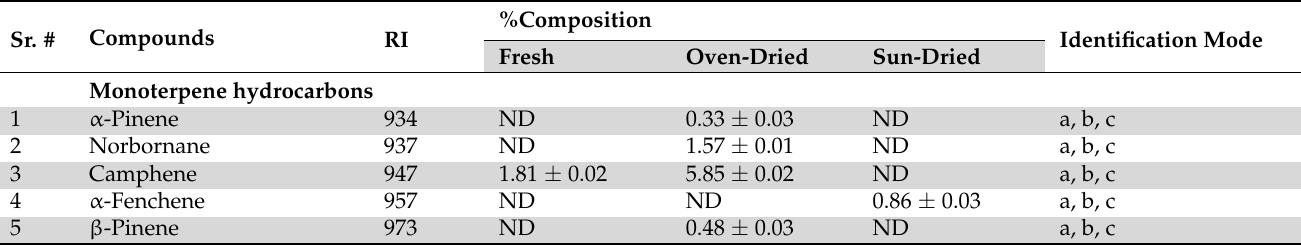
Table 2. Chemical composition of essential oil of ginger from Thailand